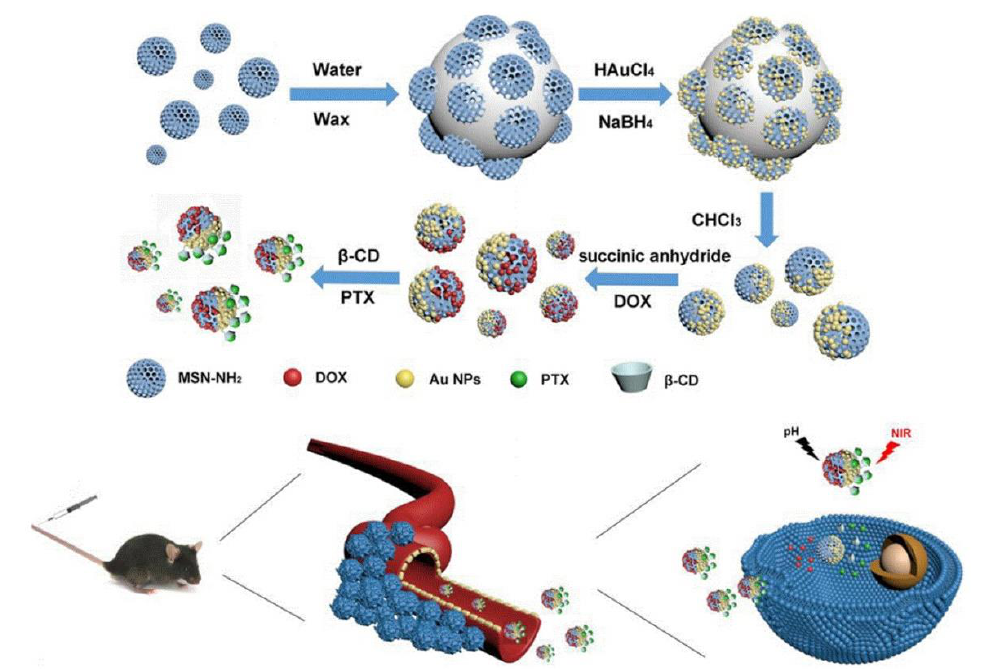
Figure 15. Schematic illustration of the preparation of PTX-Au-MSN-DOX JNPs by the Pickering emulsion method and their applications in vitro and in vivo. Reproduced from [176] with permission, copyright 2020, American Chemical Society.